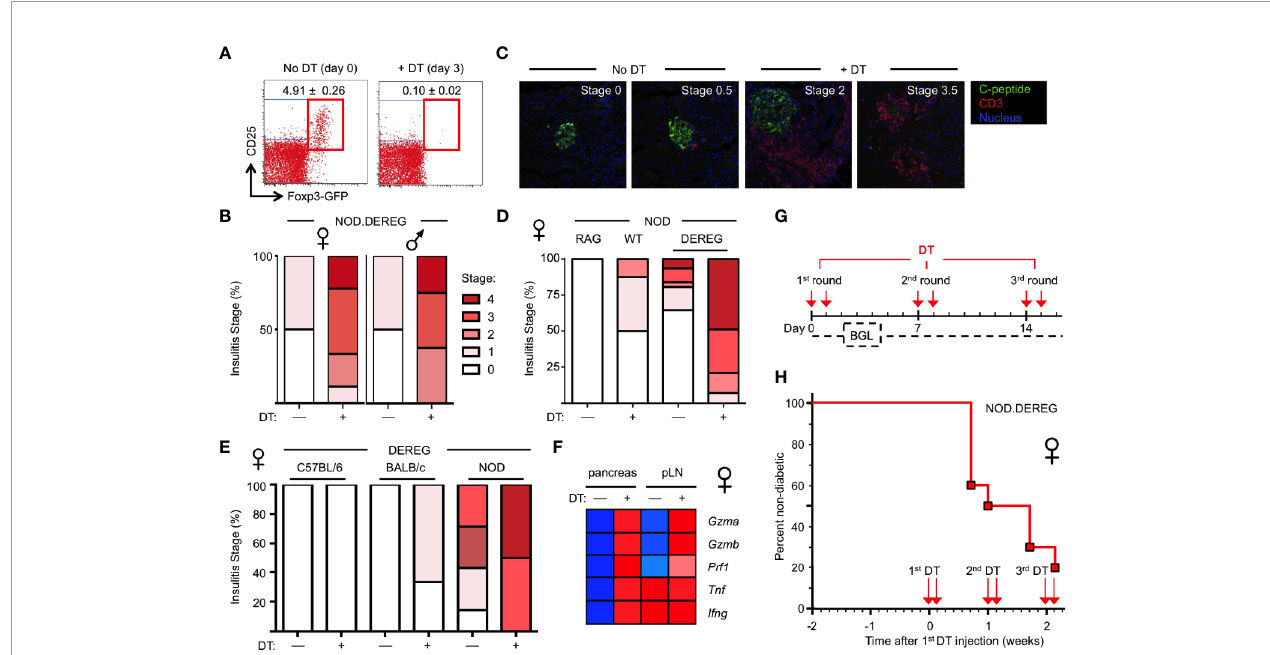
FIGURE 1 | Rapid progression to overt diabetes after acute Treg cell ablation in adult NOD.DEREG females. Mice were either left untreated or injected with DT on two consecutive days, and subjected to further analysis on day 14, unless otherwise stated. (A) Ef fi ciency of Treg cell ablation. Representative dot plots of CD4- gated cells from peripheral blood of 16-week-old NOD.DEREG females before (day 0) and after (day 3) injection with DT. Numbers in dots plots indicate mean percentage ± SD of 8 mice (unpaired t-test, p < 0.001) from a single experiment representative of 6 experiments performed (5-9 mice per experiment). (B – E) Pancreatic pathohistological changes. Histological sections were scored as described in Materials and Methods. (B) Insulitis scores of 4-5-week-old female (left, n = 10) and male (right, n = 9) NOD.DEREG mice. As all mice remained normoglycemic by day 7 after the fi rst DT injection, two additional doses of DT were administered (day 7 and 8) prior to histology on day 14. (C) Representative histology and (D) insulitis score of 8-9-week-old NOD.DEREG females (8-10 mice per group). Untreated NOD.RAG (n = 4) and DT-injected DEREG – NOD (n = 5) females were included as controls. (E) Insulitis scores of 16-week-old DEREG females on different genetic backgrounds (4-7 mice per group). (F) Expression of mRNA encoding immune effector molecules with known function in autoimmune b cell destruction. Freshly isolated mRNA from pancreas and pLN (pooled from 4-5 mice per group) of 10-12-week-old NOD.DEREG females was subjected to real-time RT-PCR using b -Actin for normalization. Heat map (row normalized) shows mean values of triplicate samples from a single experiment representative of at least two independent experiments performed. Blue and red represent lowest and highest gene expression values, respectively. Pancreas, Unpaired t-test: p < 0.001: Gzma, Gzmb, Prf1, Tnf ; p ≤ 0.01: Ifng . pLN, Unpaired t-test: p <0.001: Gzma, Gzmb ; p ≤ 0.01: Prf1 ; not signi fi cant: Tnf, Ifng . (G, H) Manifestation of overt diabetes. (G) Cohorts of 16-week-old, initially non-diabetic NOD.DEREG mice were repeatedly injected with 2 doses of DT at 5-day-intervals, as indicated. Blood glucose levels (BGL) were determined at least three times per week. (H) Diabetes incidence of female NOD.DEREG mice. Mice were considered diabetic at blood glucose levels above 200 mg/dl on at least two consecutive measurements or with blood glucose levels once above 400 mg/dl. Data are from a single experiment (n = 10) representative of > 8 experiments performed. Note that the diabetes incidence of male NOD.DEREG mice is depicted in Supplementary Figure S3